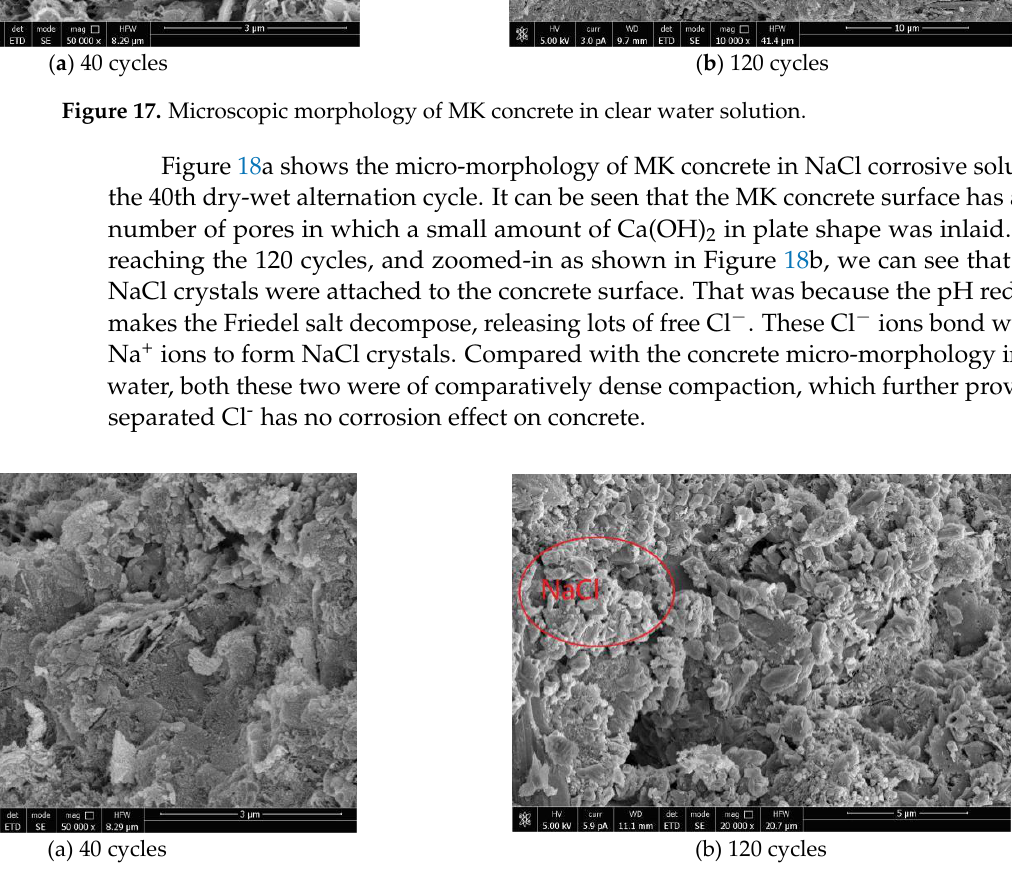
( b ) 120 cycles Figure 19. Microscopic morphology of MK concrete eroded by MgCl 2 solution.